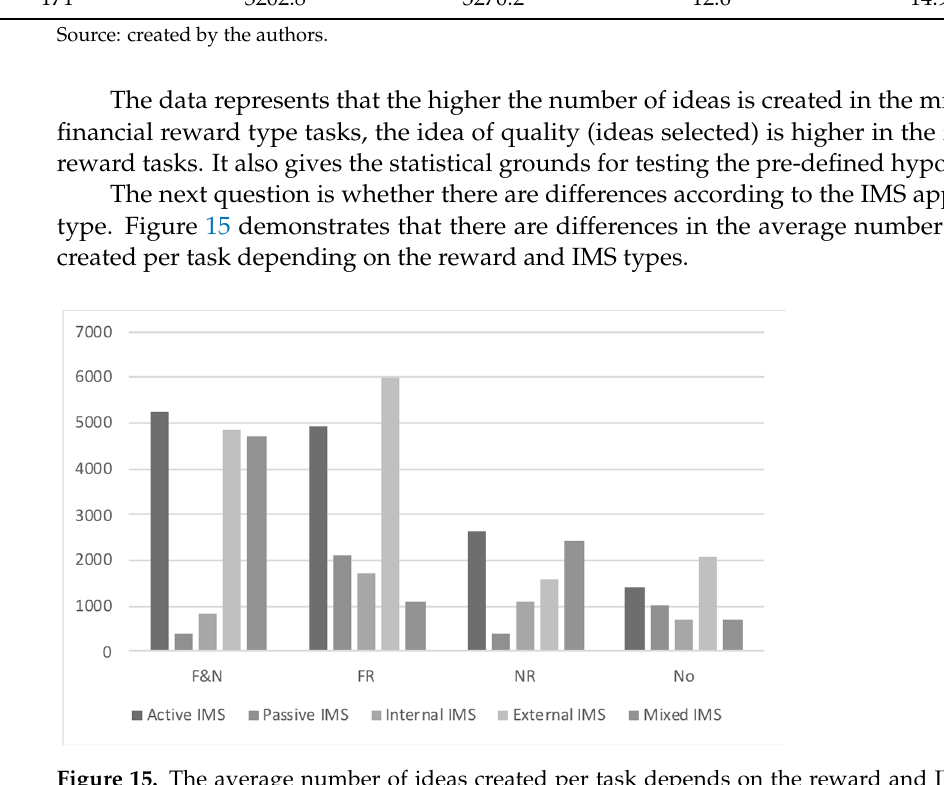
Figure 15. The average number of ideas created per task depends on the reward and IMS types. Source: created by the authors .